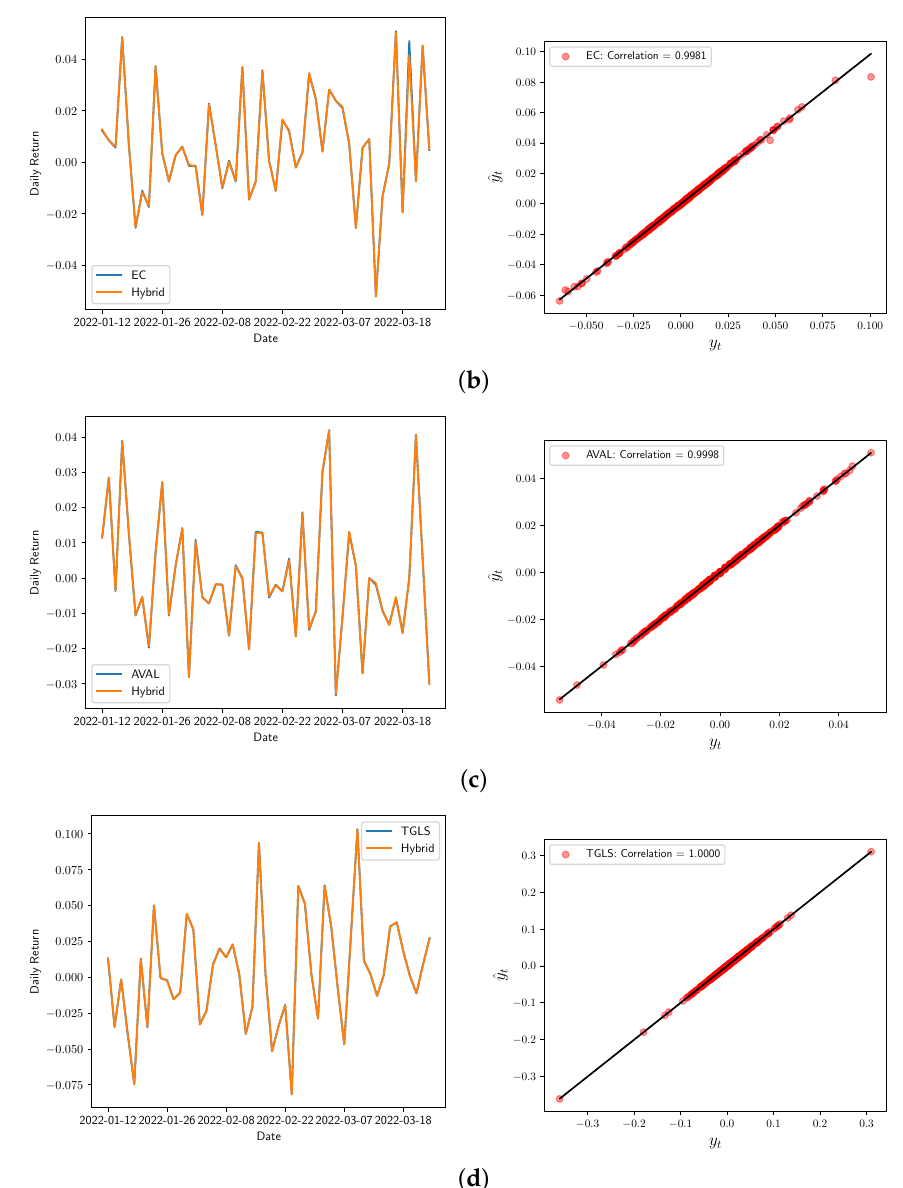
Figure 7. Real vs. Hybrid adjustment for the daily returns (left) and correlation Corr ( y t , ˆ y t ) for the real and forecasted share prices (right) of: ( a ) Bancolombia, ( b ) Ecopetrol, ( c ) Grupo AVAL, and ( d ) Tecnoglass.